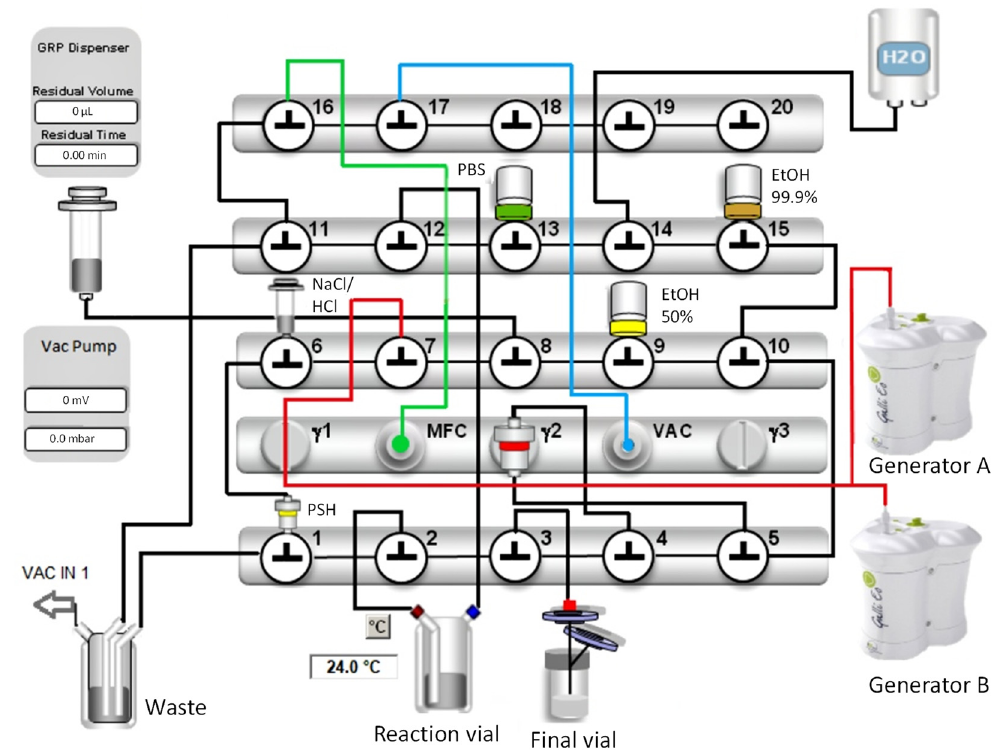
Figure 2. Synthesis scheme for the automated production of [ 68 Ga]Ga-DOTA-MGS8 using the described configuration of the synthesis module.